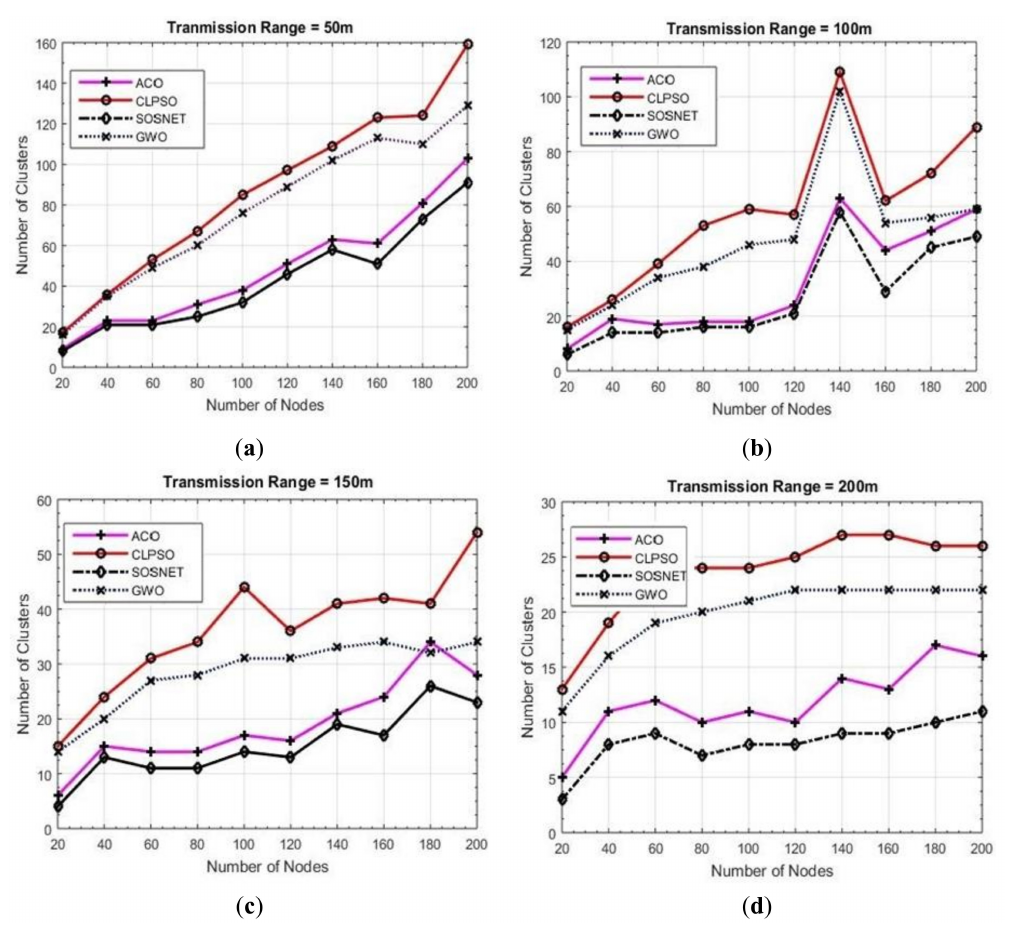
Figure 10. Grid size 2000 m × 2000 m, transmission ranges 50 to 200.